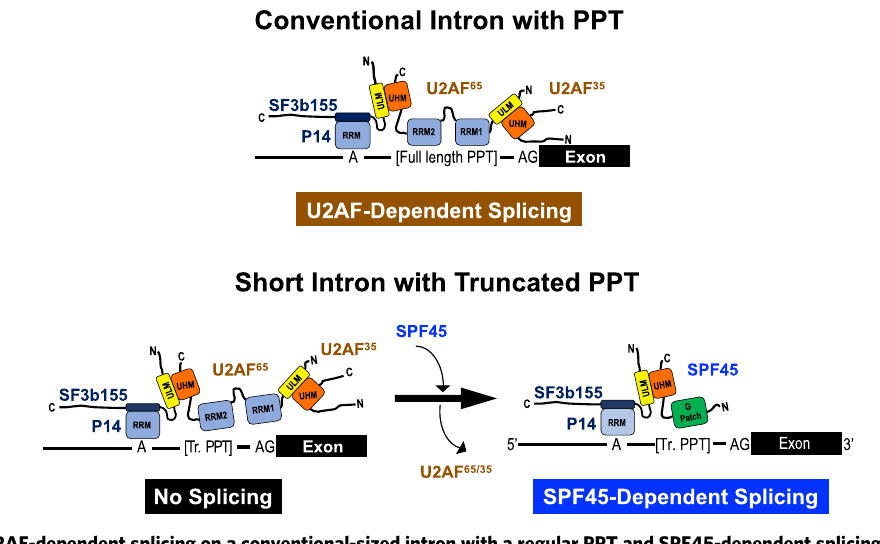
Fig. 9 The model of U2AF-dependent splicing on a conventional-sized intron with a regular PPT and SPF45-dependent splicing on a short intron with a truncated PPT. The associated splicing factors with the domain structures and the target sequences of pre-mRNAs are represented schematically. On short intron with truncated PPT (Tr. PPT), U2AF heterodimer is replaced by SPF45 and interacts with SF3b155 (U2 snRNP component) via UHM – ULM binding to promote splicing. Since both U2AF 65 and SPF45 can bind to long introns simultaneously via fi ve ULMs in SF3b155, the alternative model that U2AF 65 displaces SPF45 in long introns would be